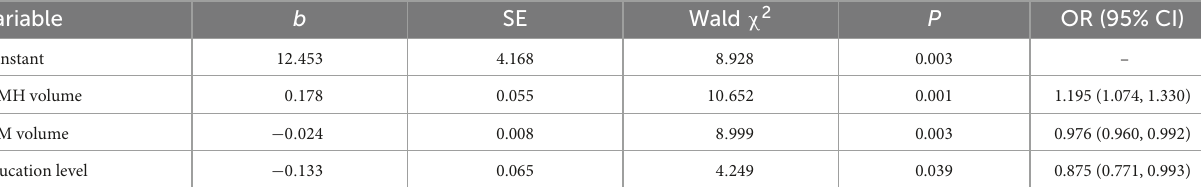
TABLE 3 Multivariable logistic analysis of factors predicting cognitive impairment.